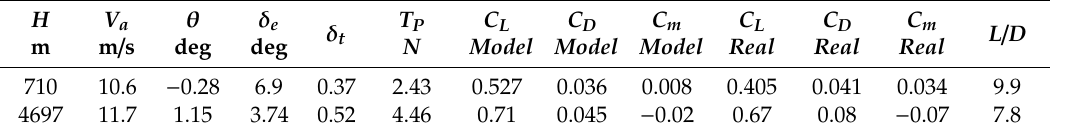
Table 11. The summary of UAV cruising parameters at low and high altitude.